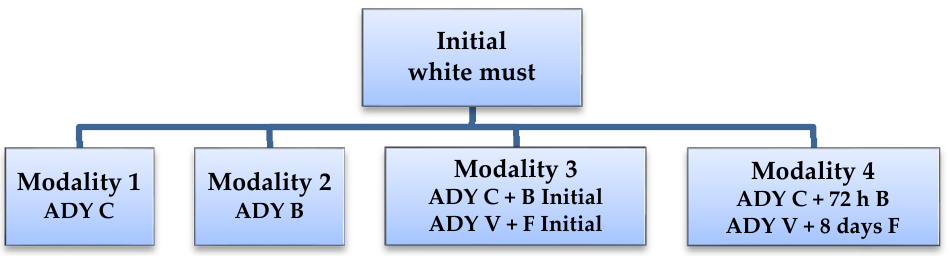
Figure 1. Schematic representation of white must experiments. Experiment 1—ADY C and B; experiment 2—ADY V and F.